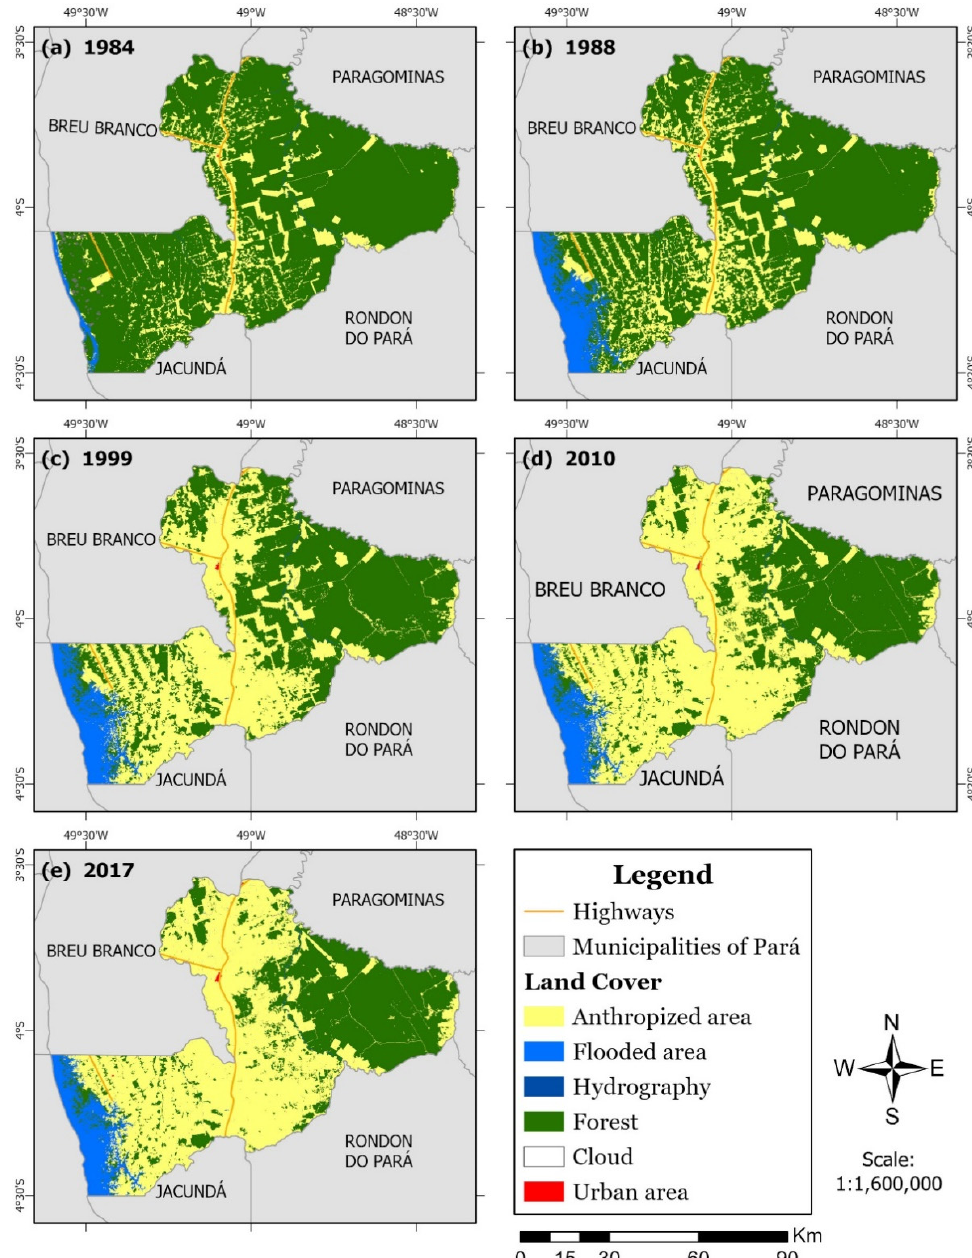
Figure 2. Thematic maps of land cover in the municipality of Goianésia do Pará, concerning the years 1984 ( a ), 1988 ( b ), 1999 ( c ), 2010 ( d ), and 2017 ( e ).